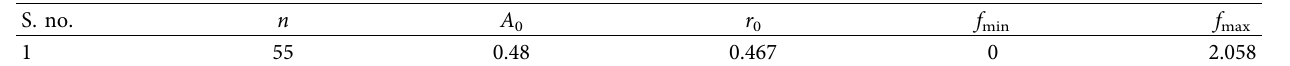
Table 10: Main parameters for the systems after